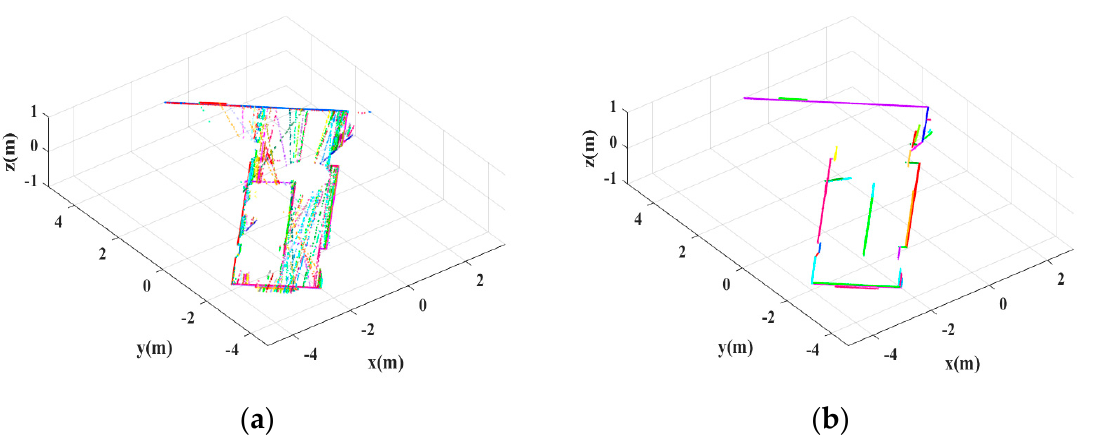
Figure 7. Comparison of line segment detection effects of two methods. Different colors represent different line segments. ( a ) Line segments detected by the RANSAC algorithm. ( b ) Line detected by the proposed algorithm.